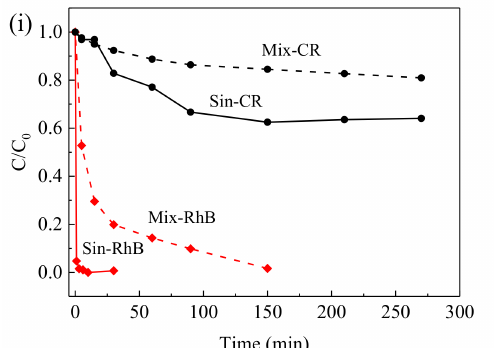
Figure 6. ( a ) UV–Vis adsorption spectra and images (inset) of the aqueous RhB solution (5 mg L − 1 , 100 mL) in the presence of the BN sample at different time interval; ( b ) Adsorption rates of RhB on the BN sample; ( c ) The percentage removal of RhB as a function of initial concentration; ( d ) the Langmuir isotherm and ( e ) the adsorption isotherm of RhB on the BN sample; ( f ) adsorption rates; ( g ) the Langmuir isotherm of CR on the BN sample; ( h ) the adsorption isotherm of CR on the BN sample; and ( i ) the removal rate of RhB (5 mg L − 1 ) and CR (10 mg L − 1 ) in single and mixed solution by adding 4 mg BN in 100 mL